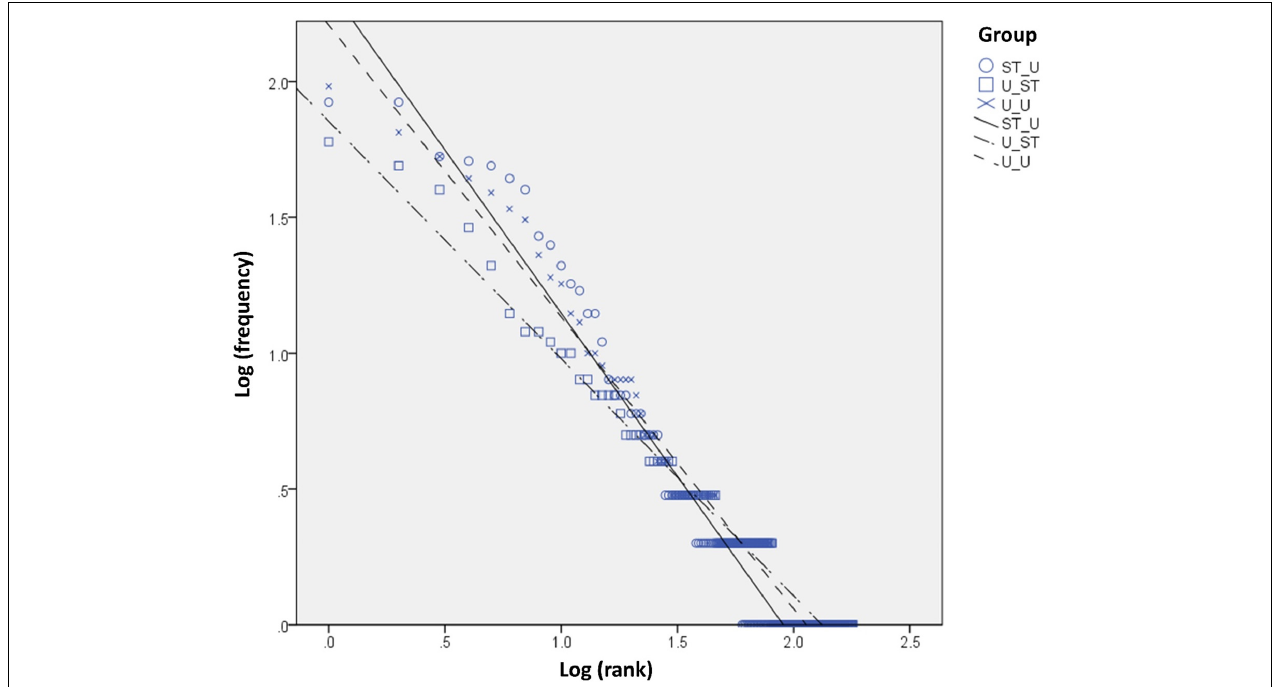
FIGURE 1 | Log–log plot by participant